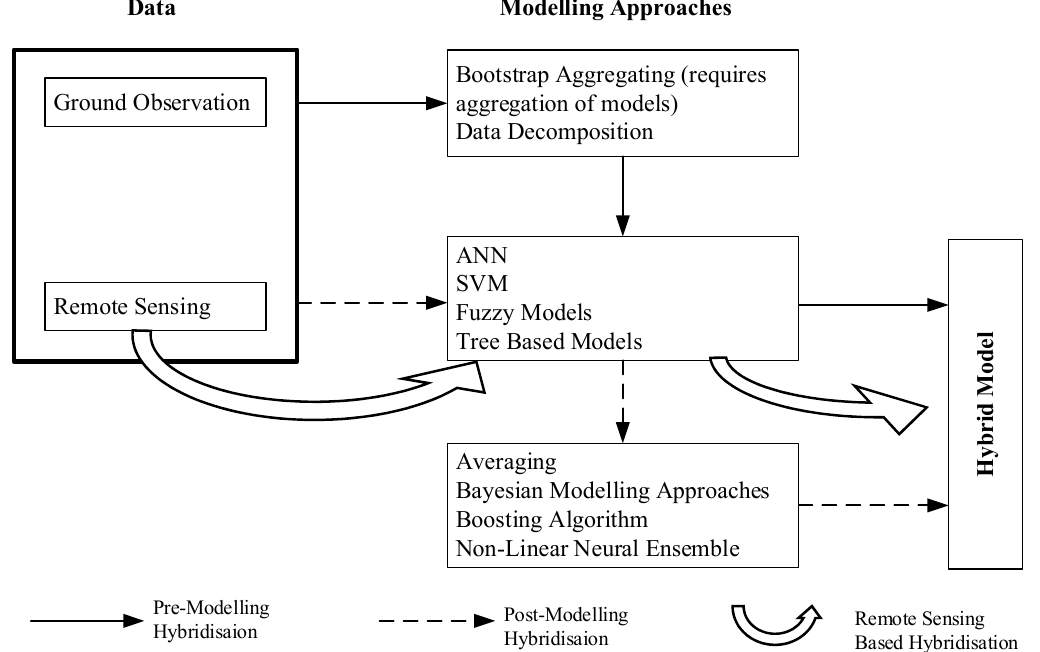
Figure 6. Pathways for hybrid model development. ANN – Artificial Neural Network; SVM – Support Vector Machine.